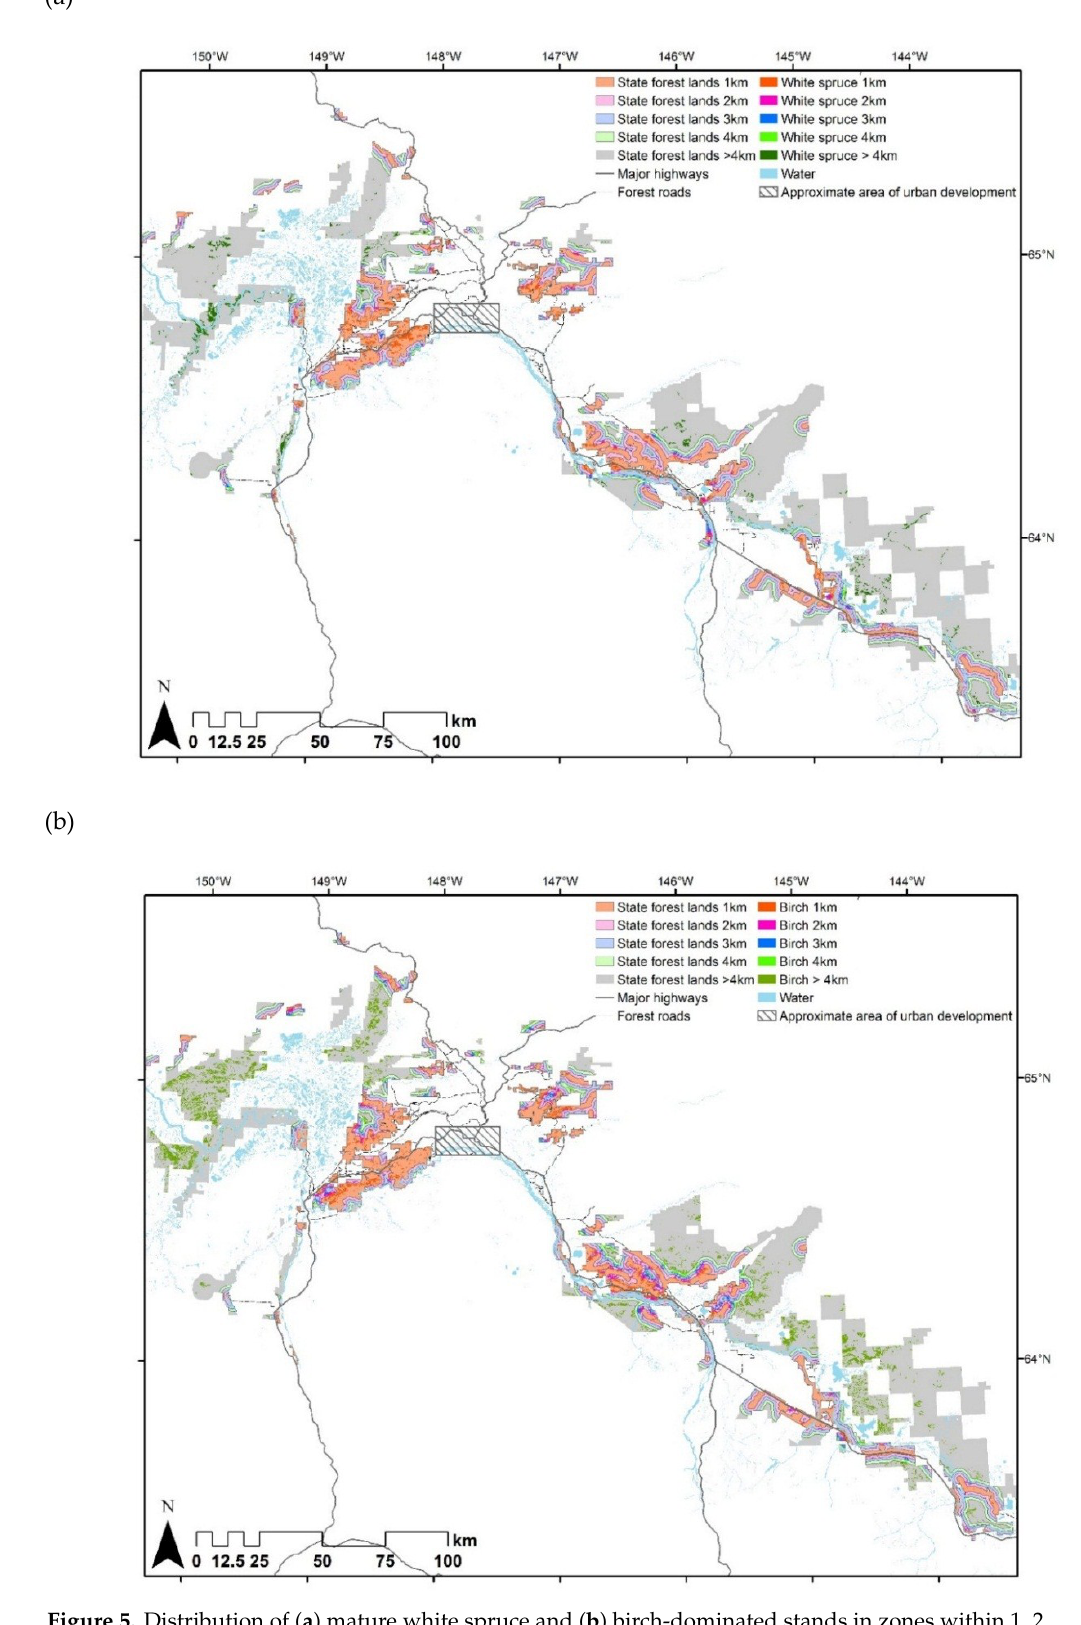
Figure 5. Distribution of ( a ) mature white spruce and ( b ) birch-dominated stands in zones within 1, 2, 3, 4, and > 4 km of road network. Birch dominated stands include mixed birch-aspen stands as well.